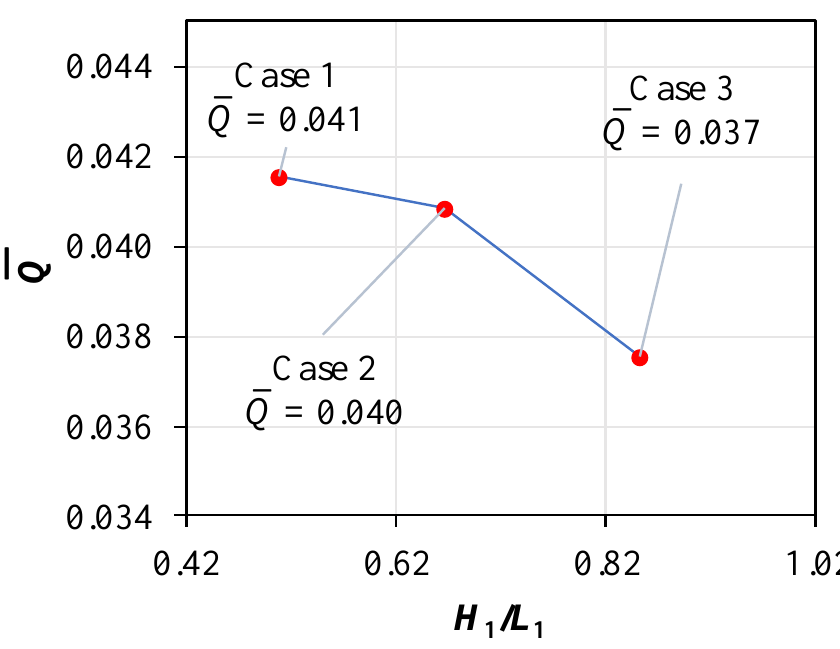
Figure 15 shows the results obtained for the numerical average dimensionless over- topping flow, Q , for the three values of the degree of freedom H 1 / L 1 , i.e., cases 1, 2, and 3. The geometric evaluation indicates that the smaller magnitudes of H 1 / L 1 led to the highest values of Q for the conditions imposed for the problem. Therefore, case 1 showed the maximum magnitude for the average dimensionless overtopping flow, ( Q mm = 0.041, with a R E = 1.59% higher if compared to case 2 and R E = 9.60% when compared with case 3, i.e., case 1 was the geometry that presented the lowest resistance to water flow from the incident waves on the OTD-WEC with one ramp, providing the highest average dimensionless overtopping flow.